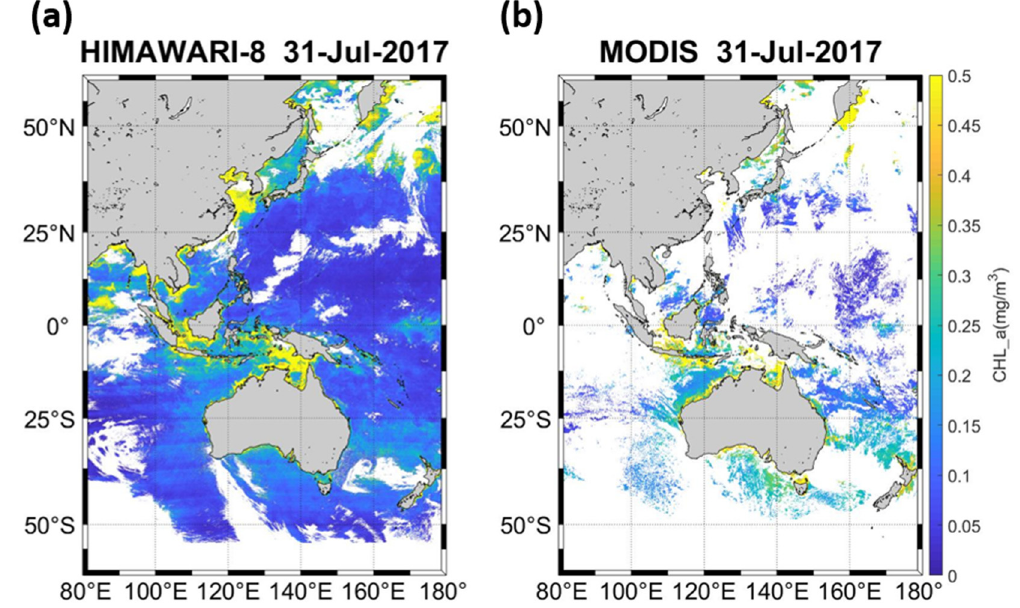
Figure 2. Daily Chl-a composites on 31 July 2017 retrieved from ( a ) AHI/Himawari-8 and ( b ) merged MODIS Aqua-Terra.